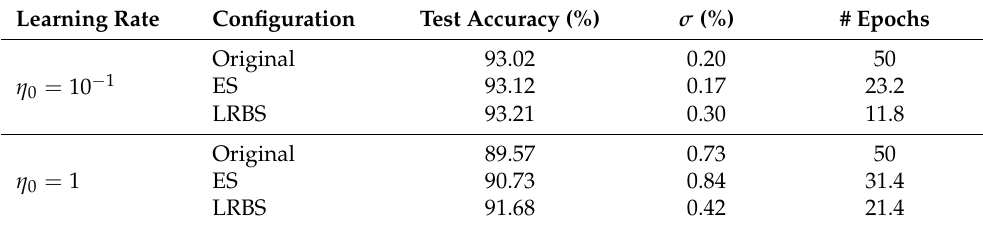
Table 7. Results on MedMNIST2D OrganSMNIST dataset in a maximum of 50 epochs.